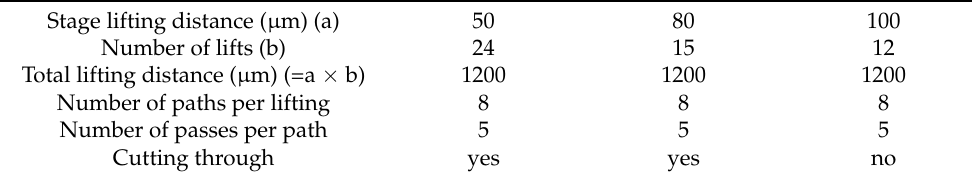
Table 6. Laser cut testing of PCD